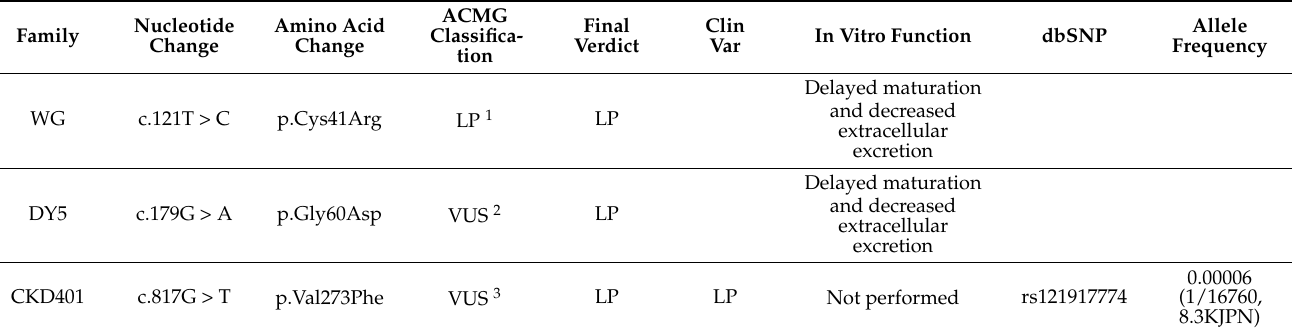
Table 1. Characteristics of UMOD variants in CKD